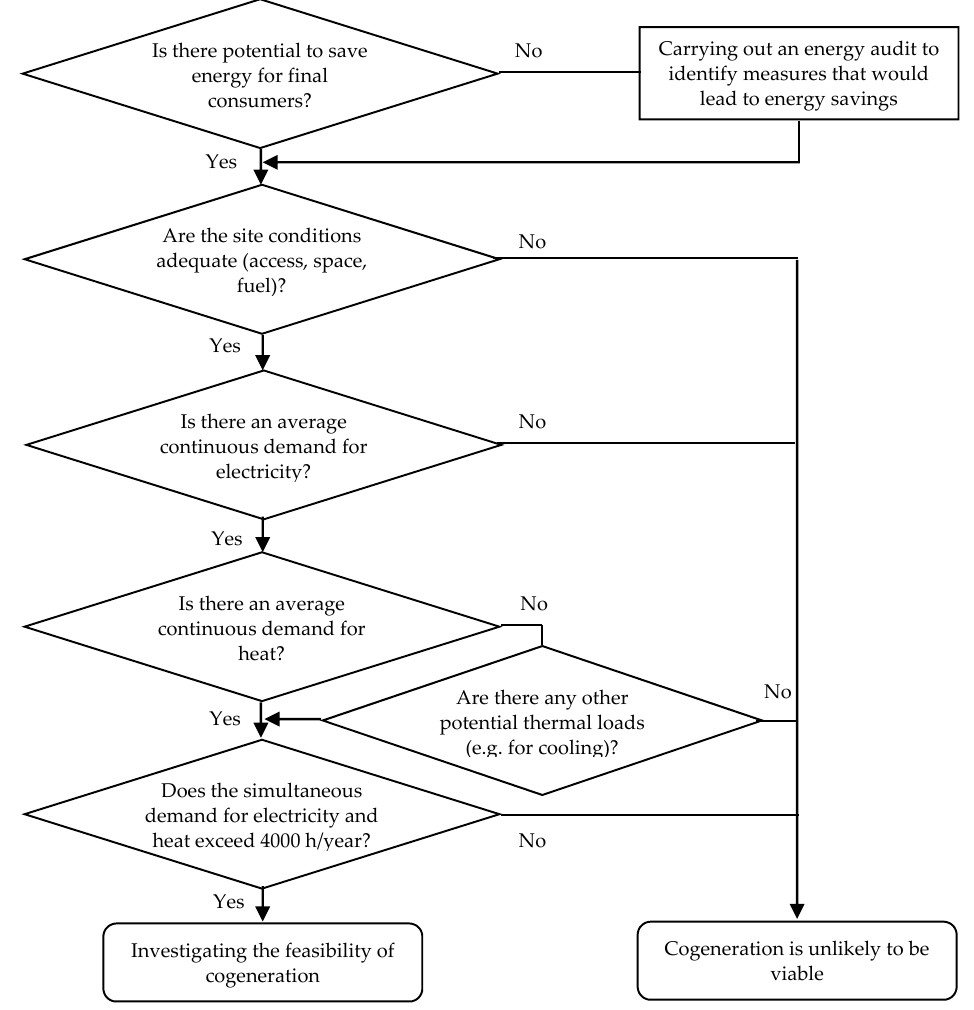
Figure 1. Initial assessment of cogeneration application.